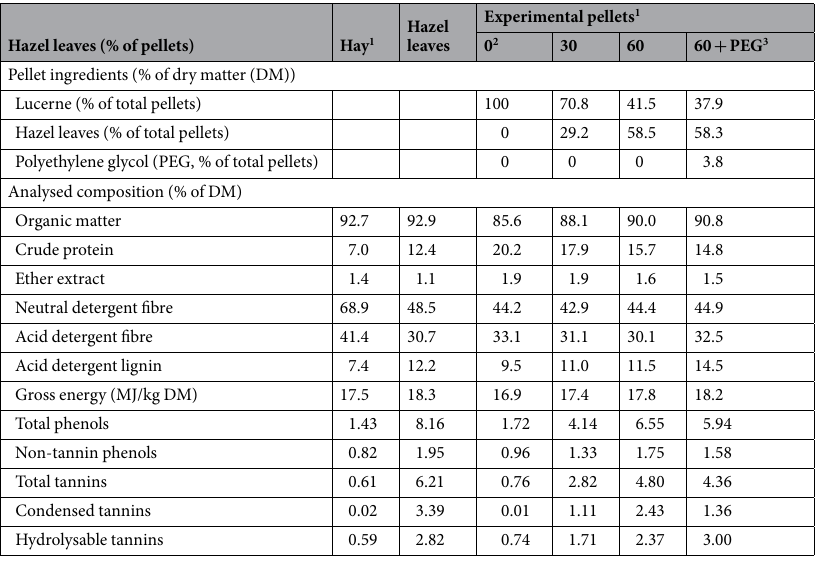
Table 1. Ingredients and chemical composition of the experimental diets * . 1 The ratio of hay to pellet was 20%: 80% in total dietary DM. 2 Equivalent to the composition of lucerne. 3 Analysis, especially of the phenols, might have been compromised by the presence of PEG. * Each animal received additionally 30 g/day of a commercial mineral-vitamin mixture (Kroni 461 Ovipress, Kroni Locher, Altstätten, Switzerland) consisting, per kg, of Ca, 140 g; P, 70 g; Mg, 40 g; Na, 50 g; Zn, 7 g; Mn, 3.5 g; Fe, 2.65 g; I, 60 mg; Co, 30 mg; Se, 40 mg; vitamin A, 400,000 IU; vitamin D 3 , 80,000 IU; vitamin E, 2 g; vitamin B 1 , 0.4 g and biotine, 0.1